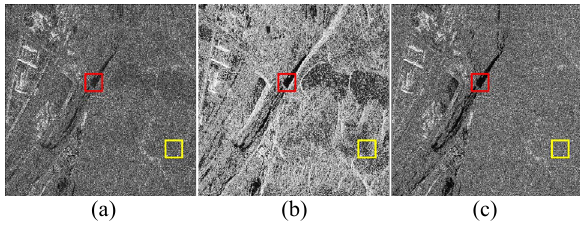
Figure 6. SAR change detection results using different change γ . (b) Mean-ratio operator in noncoherent statistics. (a) ˆ m intensity-based methods. (c) Proposed ˆ